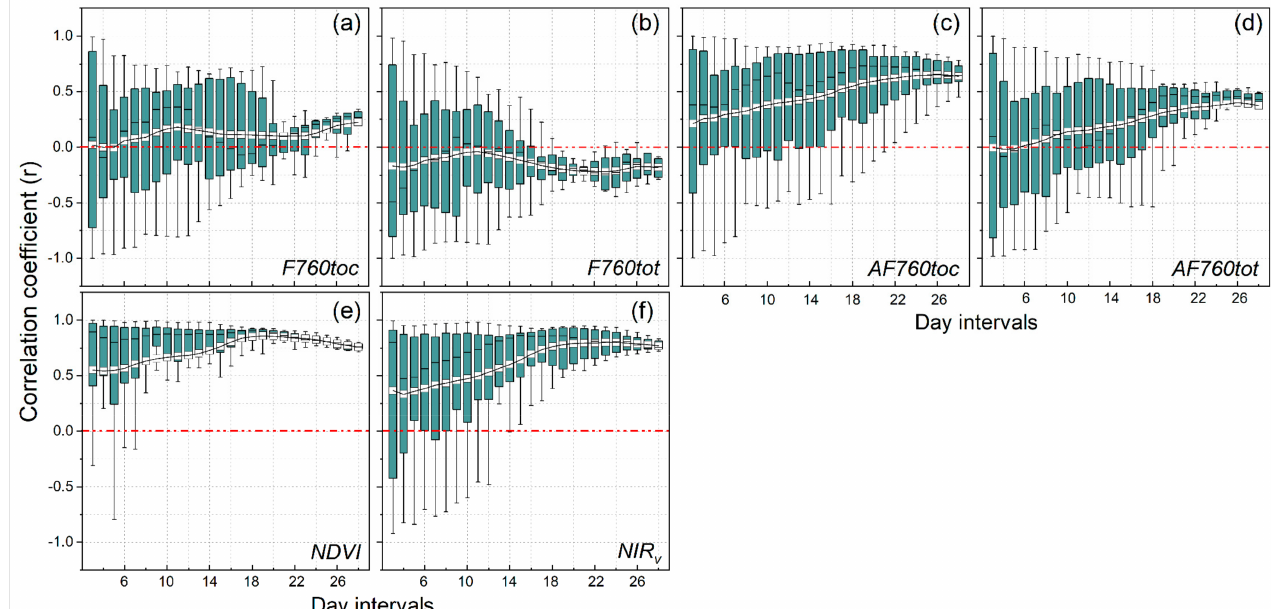
Figure 10. Boxplots of correlations between ( a ) F760toc, ( b ) F760tot, ( c ) AF760toc, ( d ) AF760tot, ( e ) the NDVI, ( f ) NIR v , and soil moisture in 20-cm soil layer from P4 with different day intervals. Each data represents the daily mean value of the measurements.